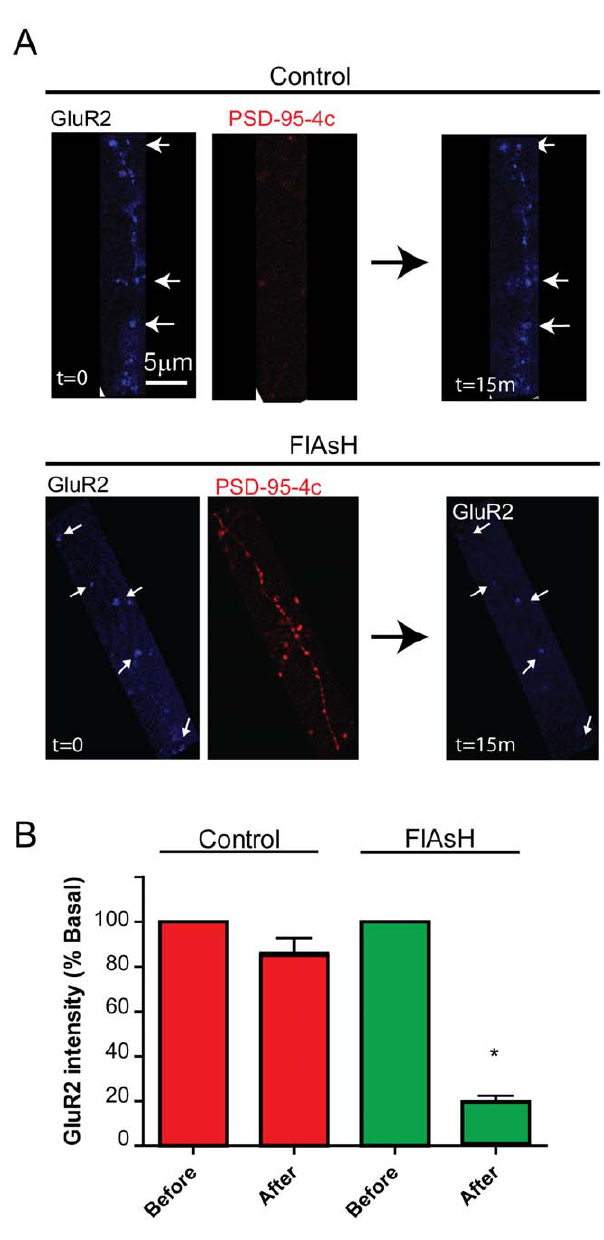
Figure 5. FALI induced rapid reduction of synaptic GluR2 staining. (A) Hippocampal cells were infected with PSD-95-4c and stained with Alexa647 conjugated anti GluR2 monoclonal antibody for confocal live cell imaging. Cells were incubated with FlAsH-EDT2, washed and mounted in a closed chamber at 37 u C. Neighboring infected and non-infected dendrites were imaged for direct compar- ison. Images were taken before (t=0 min) and 15 minutes after FALI protocol (t=15 min). GluR2 are indicated by arrows. (B) Quantification of GluR2 surface staining intensities before and after FALI. Non-infected dendrites showed no significant decrease in GluR2 signal intensity (86% 6 7, n =42). By contrast, infected dendrites showed a marked decreased compared to the initial intensity (20 6 2%, n